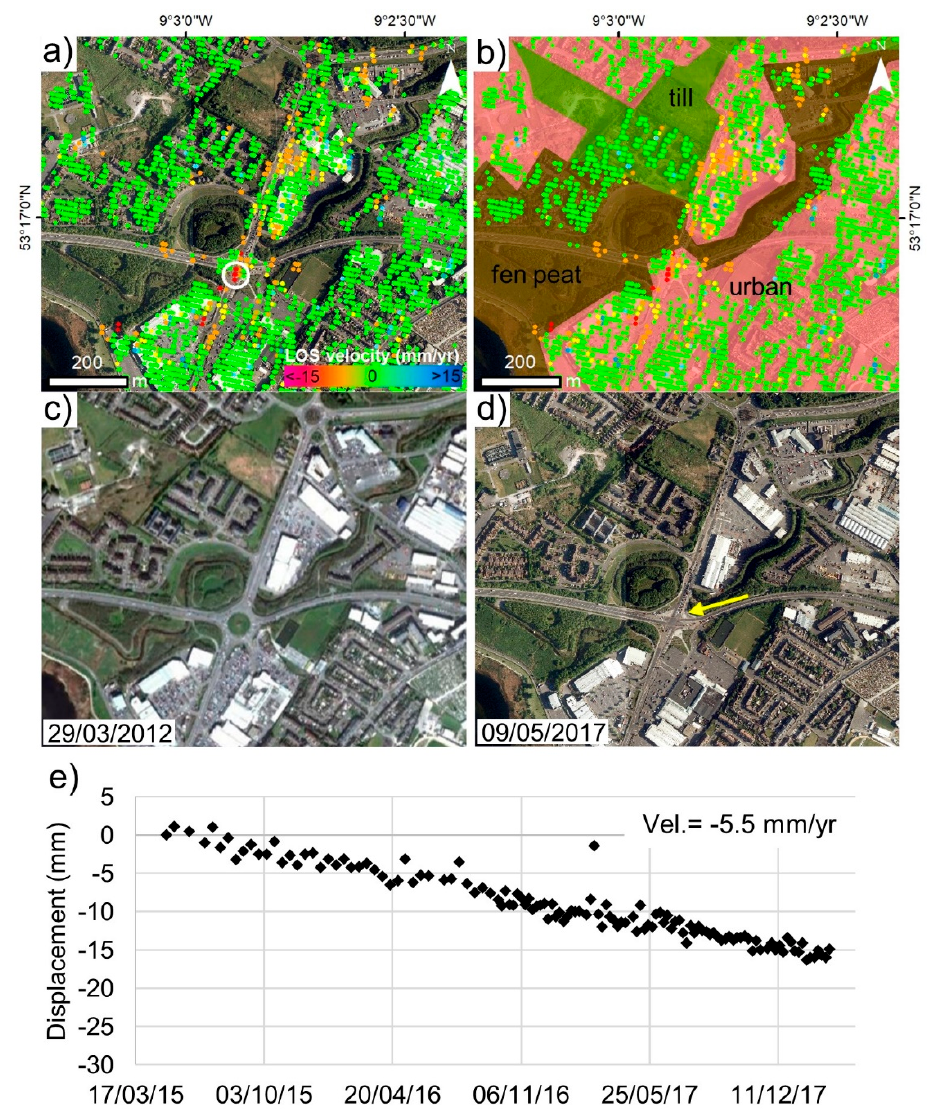
Figure 9. Example of InSAR-detected subsidence in Galway city, denoted locality ‘a’ in Figure 7: PSs are superimposed on ( a ) the 2017 BlueSky aerial orthoimage and ( b ) a map of the Pleistocene-Holocene superficial deposits; the colors correspond to the legend in Figure 4b. The white circle marks the location of the extracted displacement time series ( e ). The urban development of the area at the N6/N84 roads intersection (marked by the yellow arrow) is presented in ( c ) and ( d ). A similar pattern is observed in a semi-urbanized area marked as locality ‘b’ in Figure 7 and located north of Galway city along the N84 (Figure 10a). Here, the local subsidence zones correspond to recent land-use changes made to an area of cut-over raised peat (Figure 10b) between 2006 and